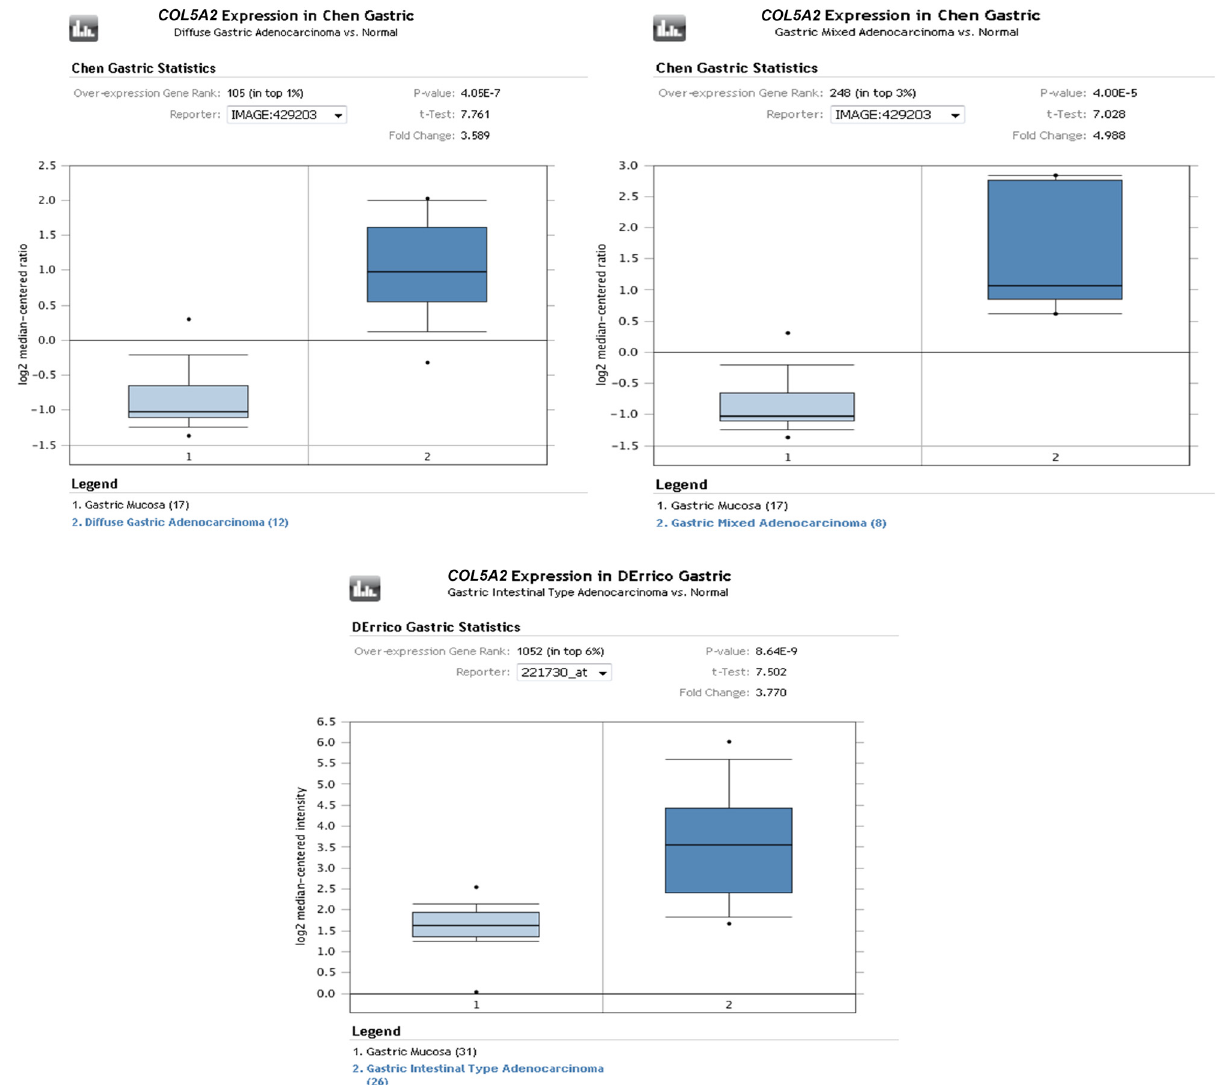
Figure A2: The mRNA expression of COL5A2 was evidently elevated in three common histological subtypes of gastric cancer including intestinal, di ff used and mixed gastric adenocarcinomas in Chen and DErrico